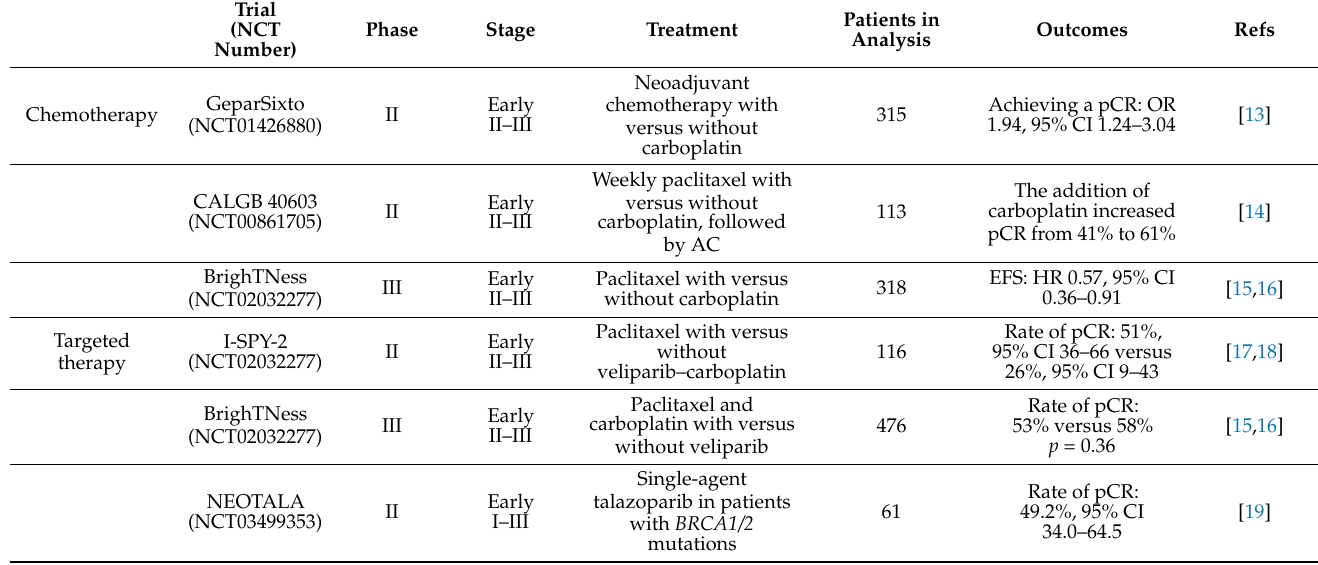
Table 2. Neoadjuvant Triple Negative Breast Cancer TNBC curative-intent